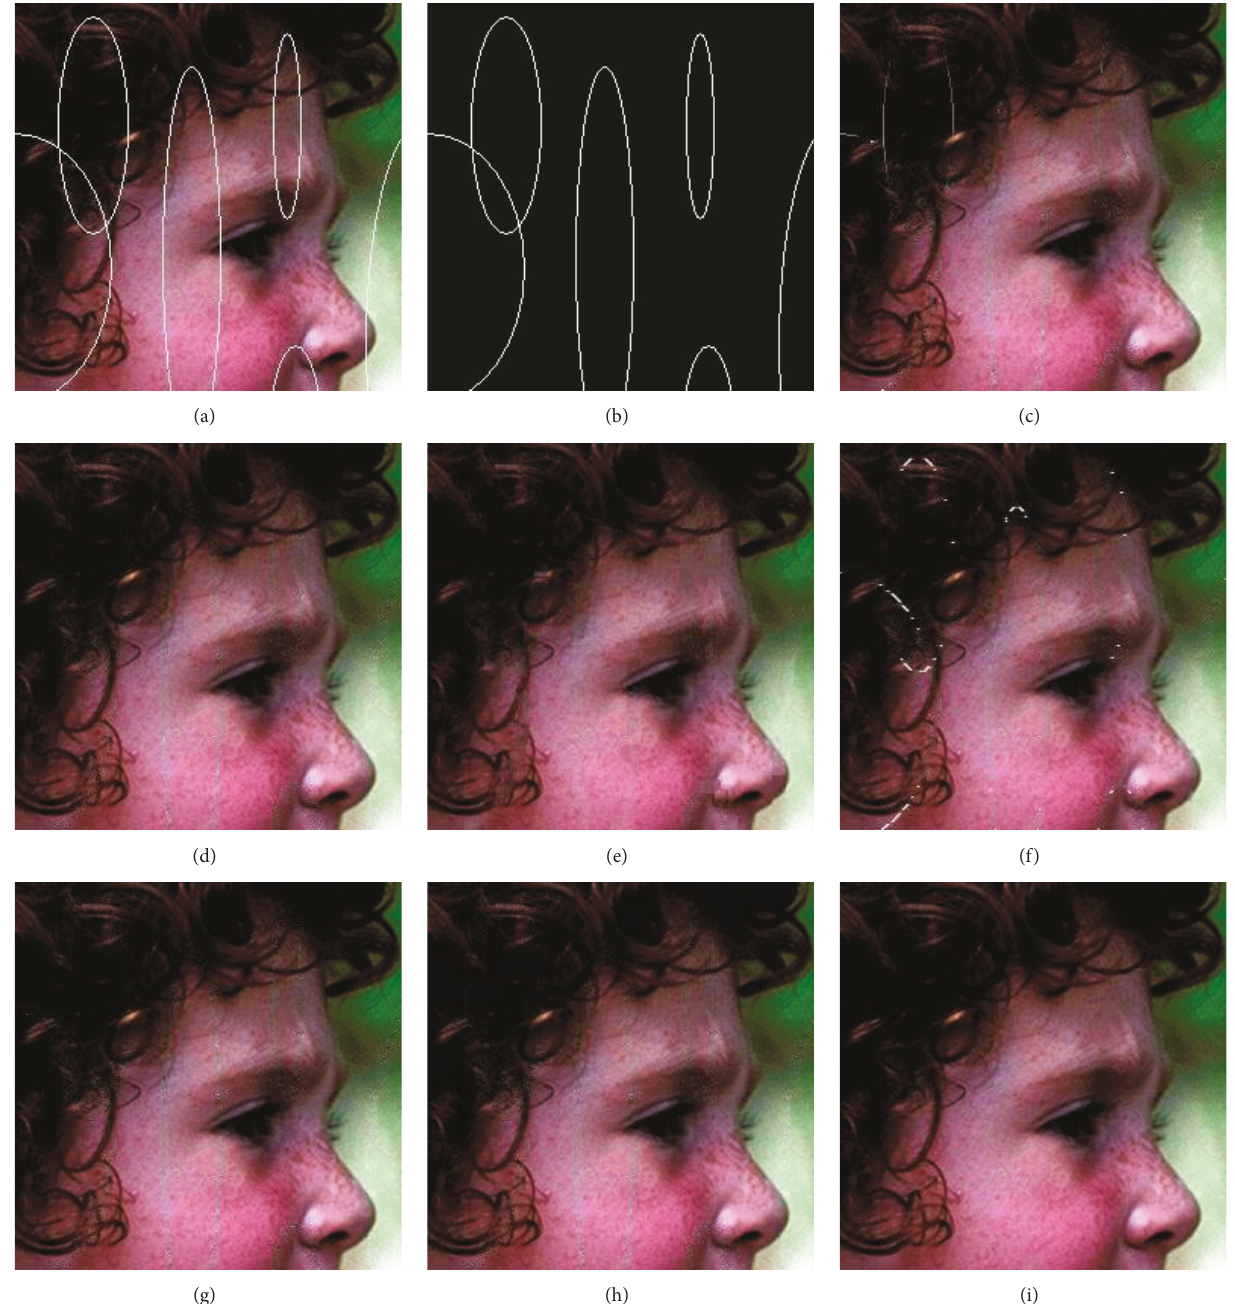
Figure 9: Repaired girl images by different inpainting methods. (a) The damaged image; (b) the mask image; (c) by BSCB; (d) by CT; (e) by EB; (f) by TV; (g) by Thiele; (h) by our method; (i) the original image.